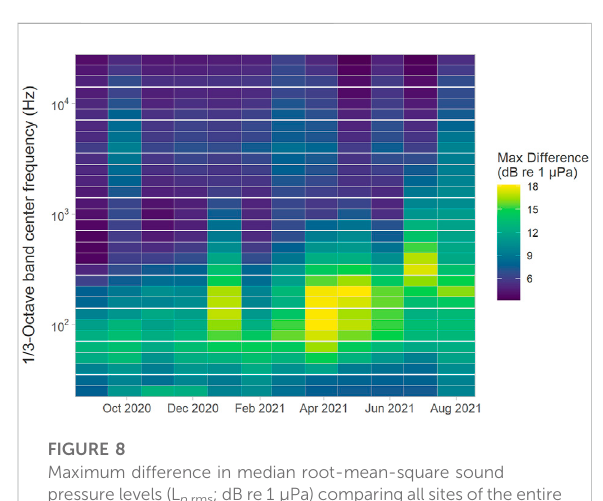
FIGURE 8 Maximum difference in median root-mean-square sound pressure levels (L p ,rms ; dB re 1 μ Pa) comparing all sites of the entire array for each month ( x -axis) and 1/3-octave band ( y